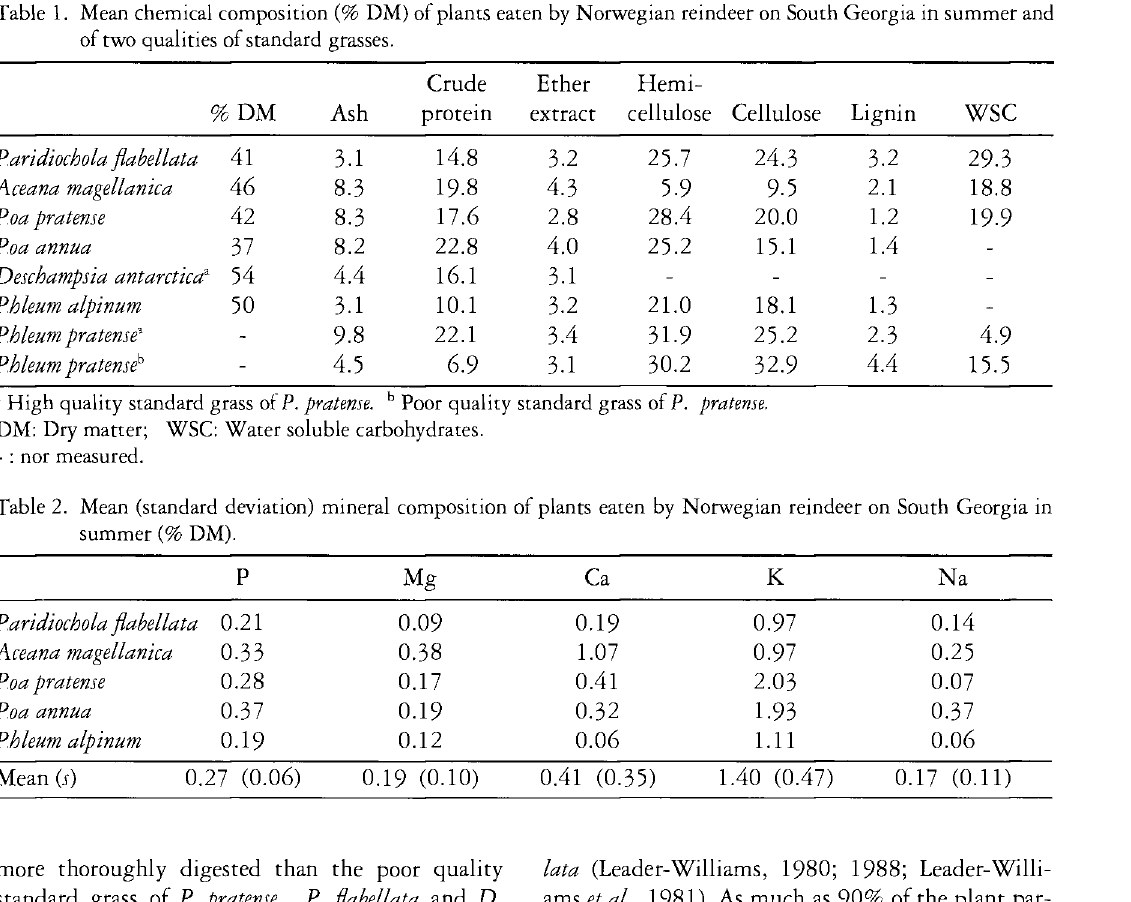
Table 2. Mean (standard deviation) mineral composition of plants eaten by Norwegian reindeer on South Georgia in summer (% DM). P Mg Ca K Na Paridiochola flabellata